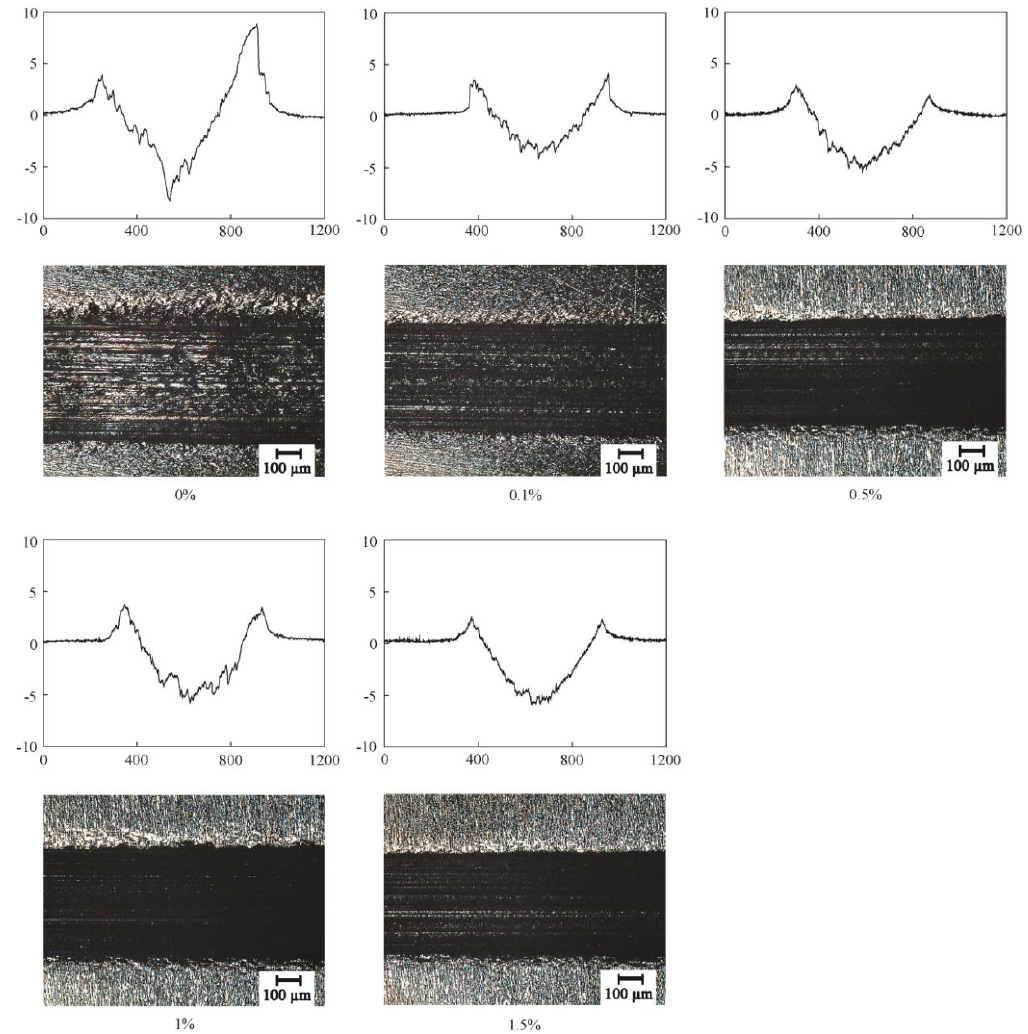
Figure 5. 2D profile curves and high-power microscopy images of the wear scars lubricated by base oil with different concentrations of micro-lamellar MoO 3 additives.